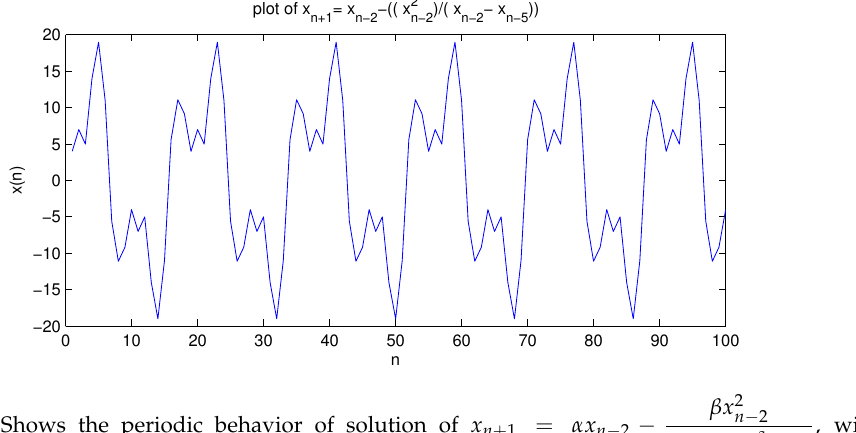
Figure 6. Shows the periodic behavior of solution of x n + 1 = α x n − 2 − x − 5 = 4, x − 4 = 7, x − 3 = 5, x − 2 = 14, x − 1 = 19, x 0 =